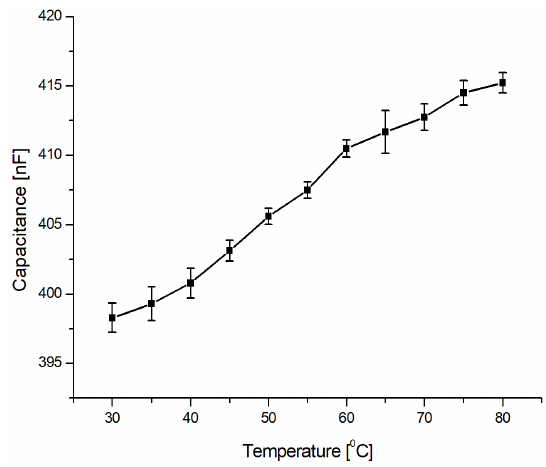
Figure 9. The variation of the solar cell capacitance depending on temperature.